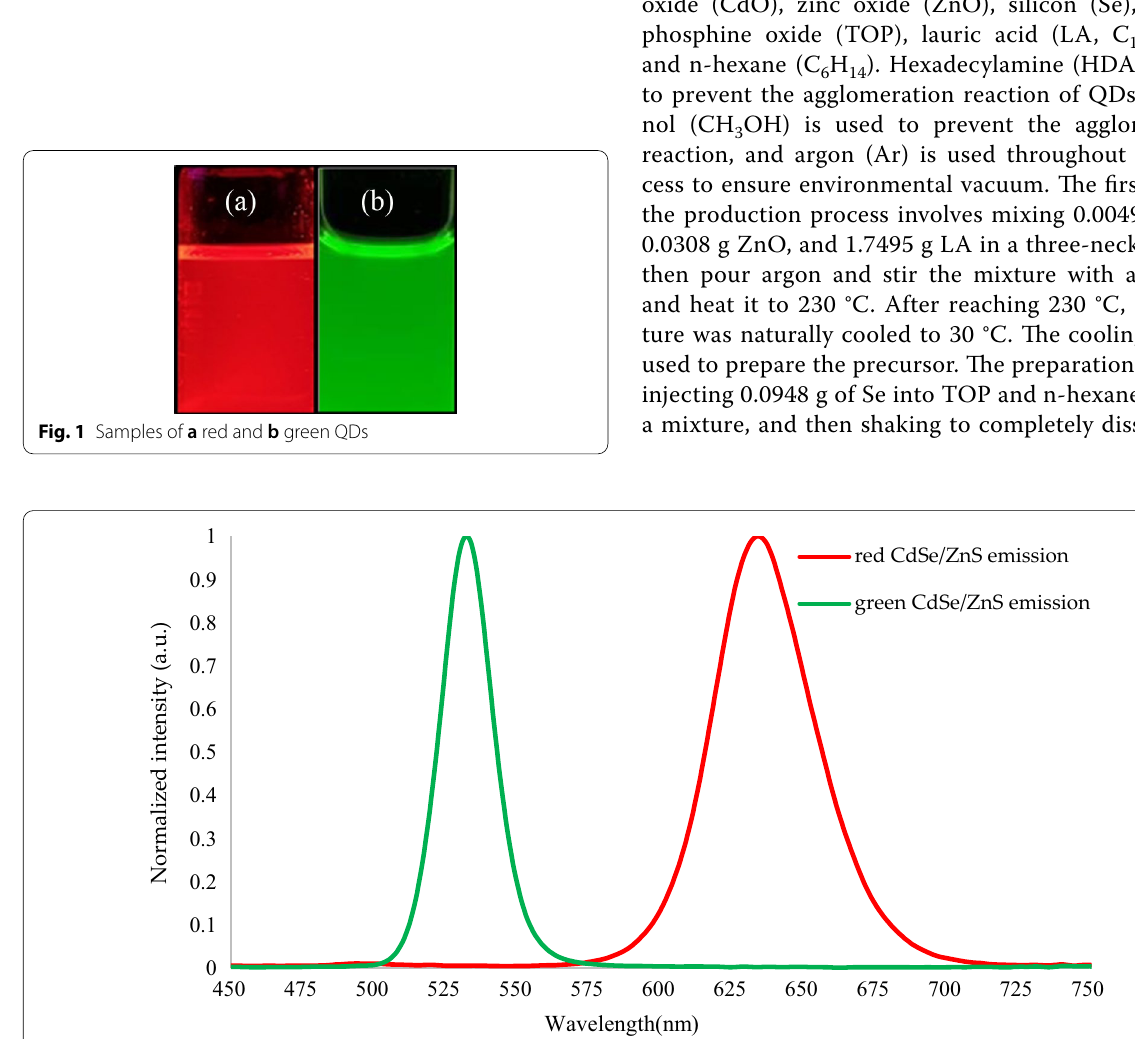
Fig. 2 Schematic diagram of the normalized spectral radiance of red and green